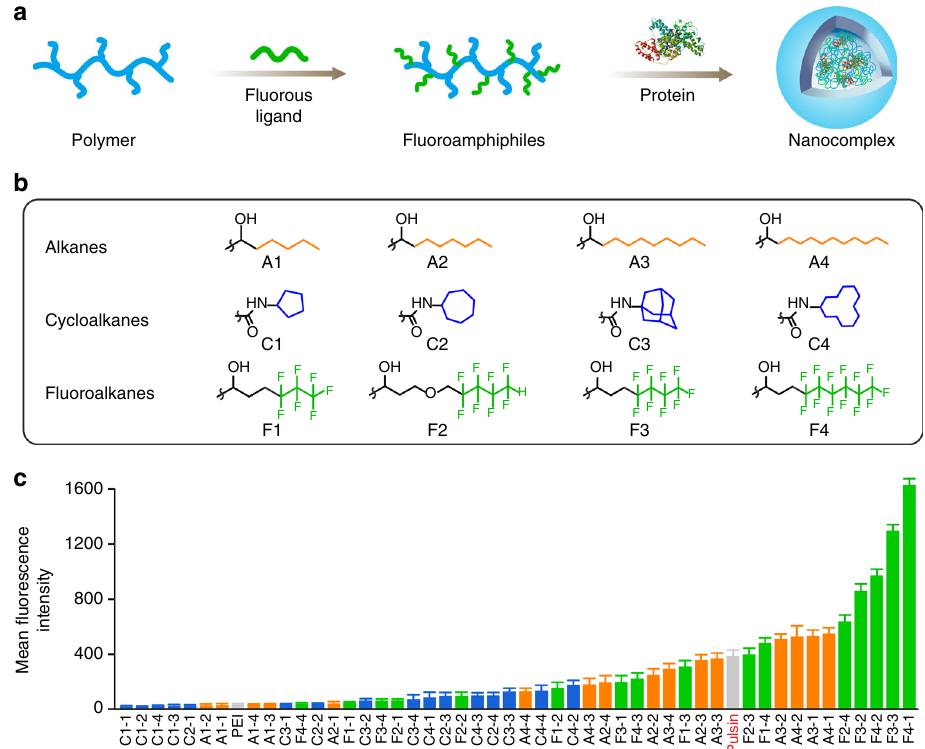
Fig. 1 Fluoroamphiphiles for cytosolic protein delivery. a Co-assembly of fl uoroamphiphiles and proteins. b Structures of hydrophobic substituents coupled to PEI. A1-A4 alkanes, C1-C4 cycloalkanes, F1-F4 fl uoroalkanes. c Mean fl uorescence intensity of cells transfected with nanocomplexes after trypan blue treatment. Data are presented as the mean ± s.e.m. ( n =